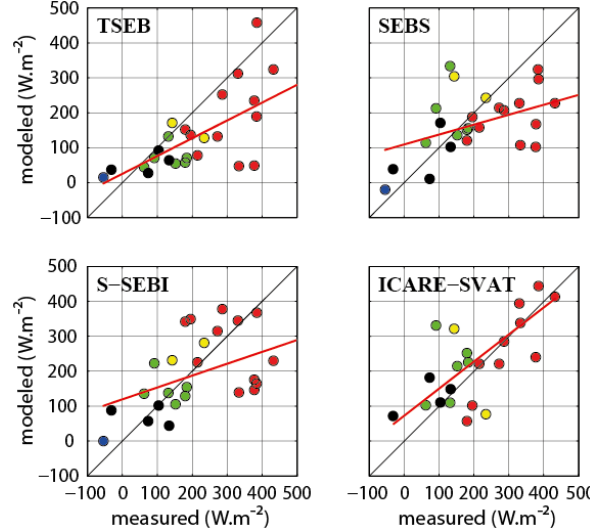
Fig. 7. Simulated versus measured sensible heat flux H for every station at ASTER overpass dates. Color code: red: LAI < 0.4; yellow: 0.4 ≤ LAI < 0.8; green: 0.8 ≤ LAI < 1.2; navy- blue: 1.2 ≤ LAI < 2.0; black: LAI ≥